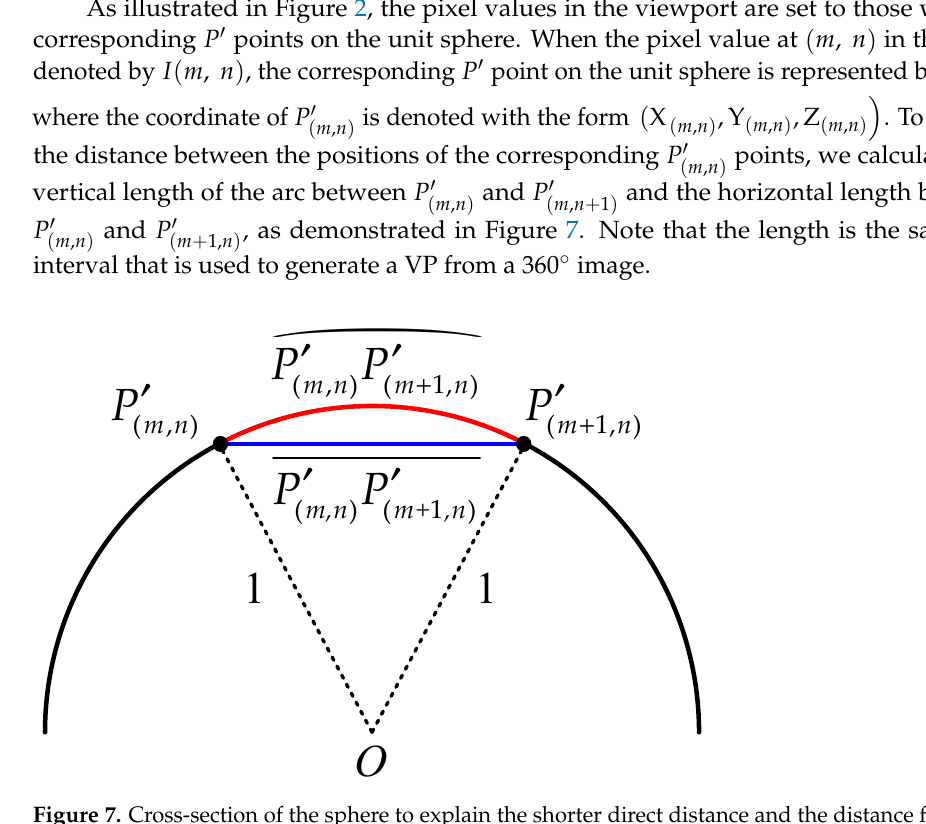
Figure 7. Cross-section of the sphere to explain the shorter direct distance and the distance following the curved surface between P (cid:48) In Figure 7, d h ( m , n ) = (cid:4698) P direct distance and the length of the arc between the horizontally nearest P (cid:48) bors. Similarly, d v ( m , n ) and l v ( m , n ) are the values for the vertically nearest neighbors, respectively, as